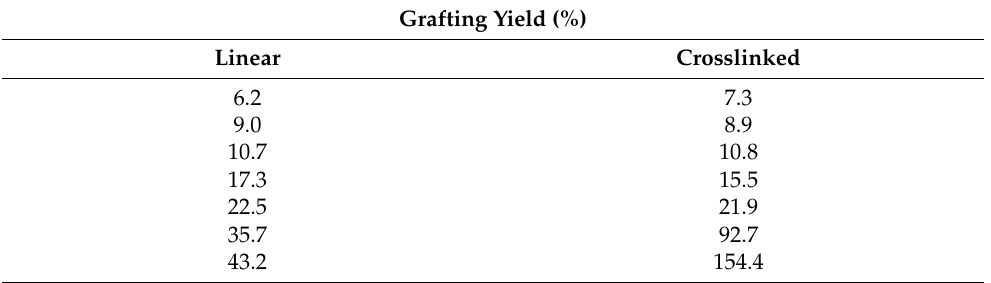
Table 1. Grafting yields of PNIPAm-grafted nylon